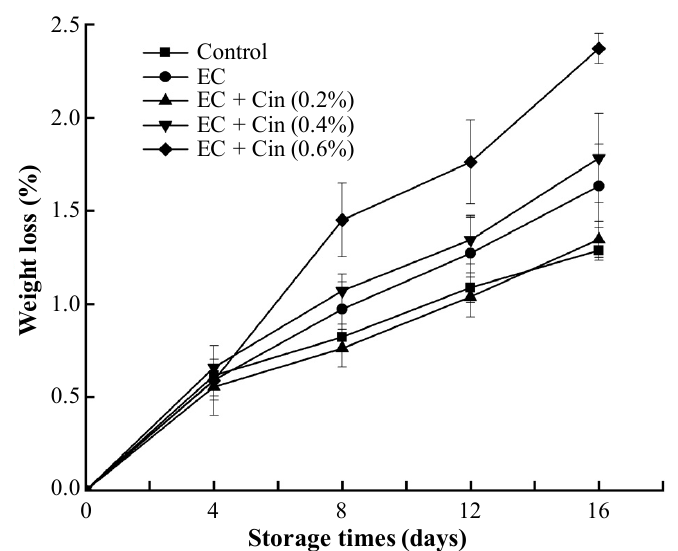
Figure 3. Changes in weight loss of fresh-cut potatoes coated with chitosan-based EC containing cinnamon oil. Control: uncoated; EC: edible coating; Cin: cinnamon oil. Bars represent means ± SD ( n = 3, p < 0.05).